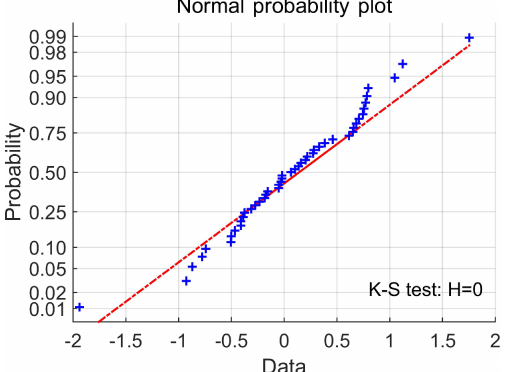
Table A1. Trends in snow depths with the Durbin–Watson test across Eurasia during